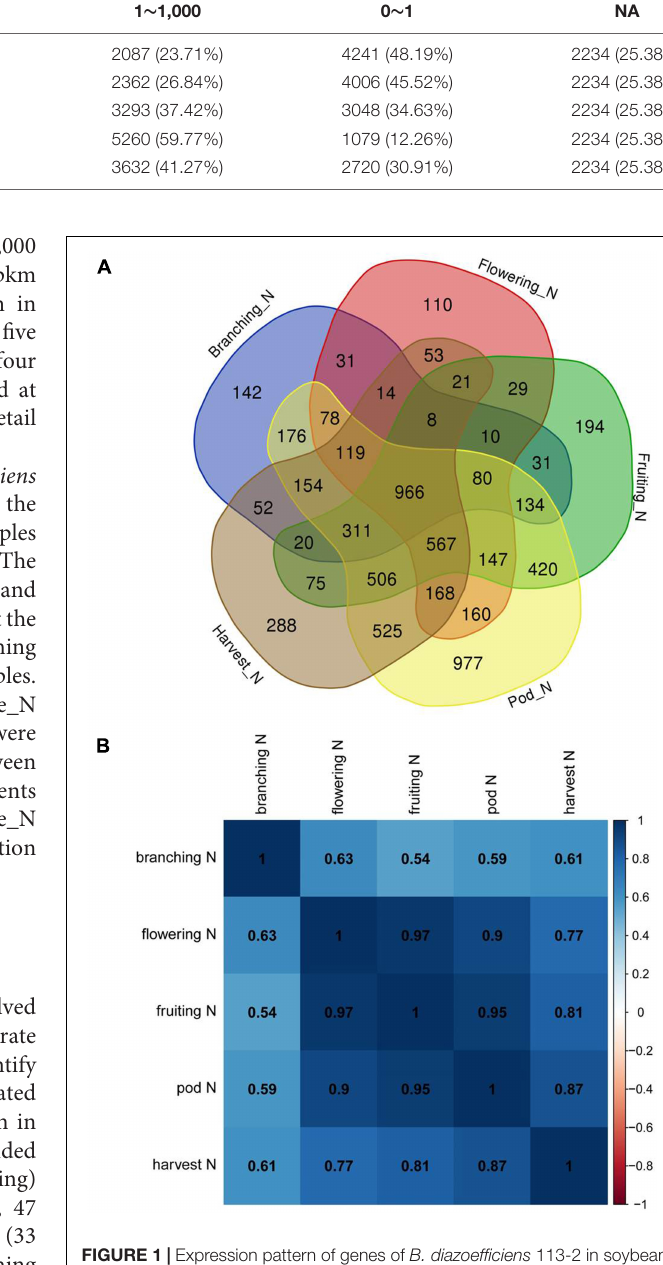
FIGURE 1 | Expression pattern of genes of B. diazoefficiens 113-2 in soybean nodules at five developmental periods of soybean. (A) Venn diagram showing the number of genes identified in nodules at branching, flowering, fruiting, pod and harvest stages. (B) Correlation between different nodule samples according to the total gene expression